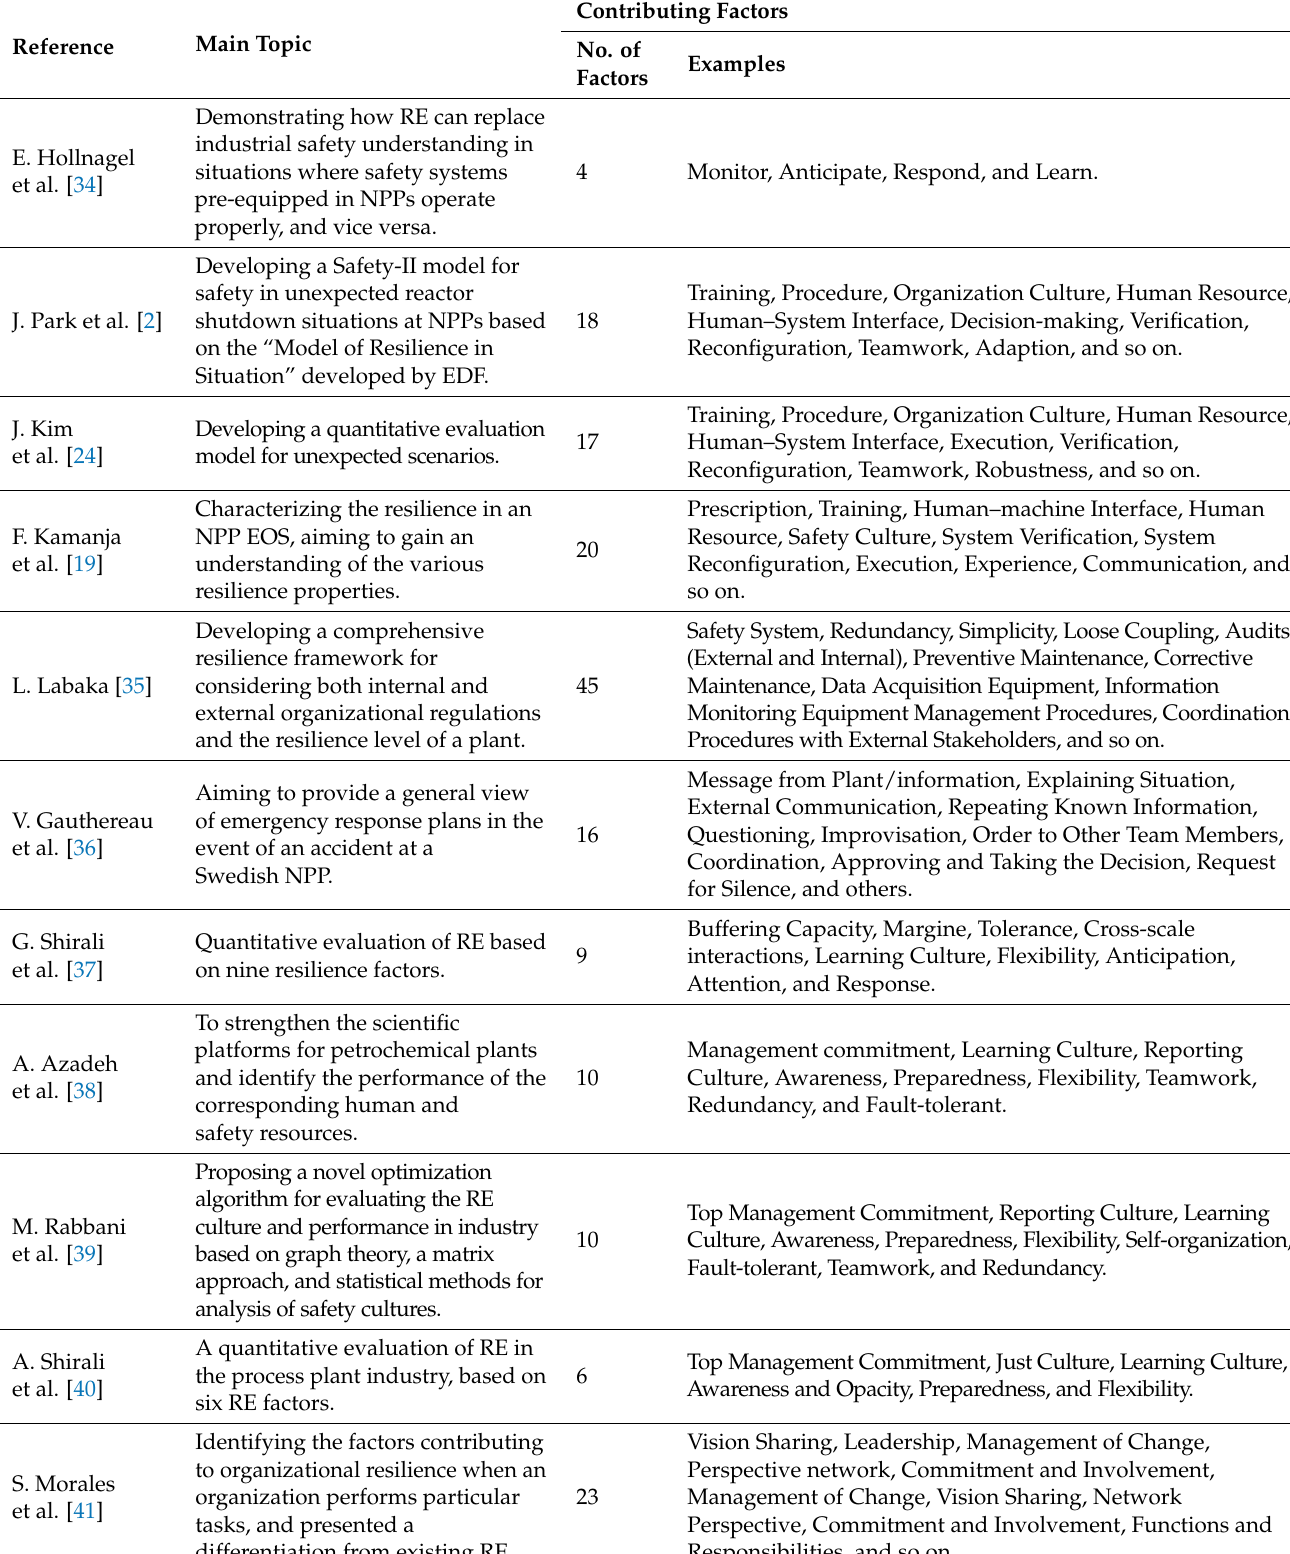
Table 2. Summary of identified contributing factors from the process plant